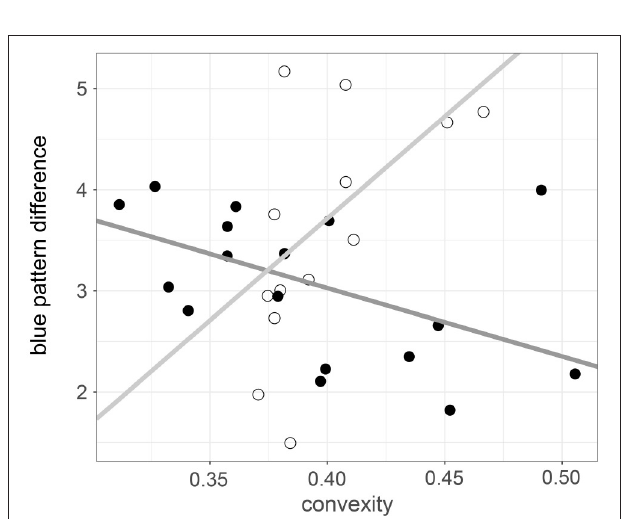
FIGURE 7 | Blue pattern differences between Acacia and Eucalyptus feeding species. Closed circles represent the raw data of Acacia -feeding species while open circles represent the raw data points of Eucalyptus -feeding species. The dark gray line represents the phylogenetically-corrected regression for Acacia -feeding species while the light gray line represents the phylogenetically-corrected regression for Eucalyptus -feeding